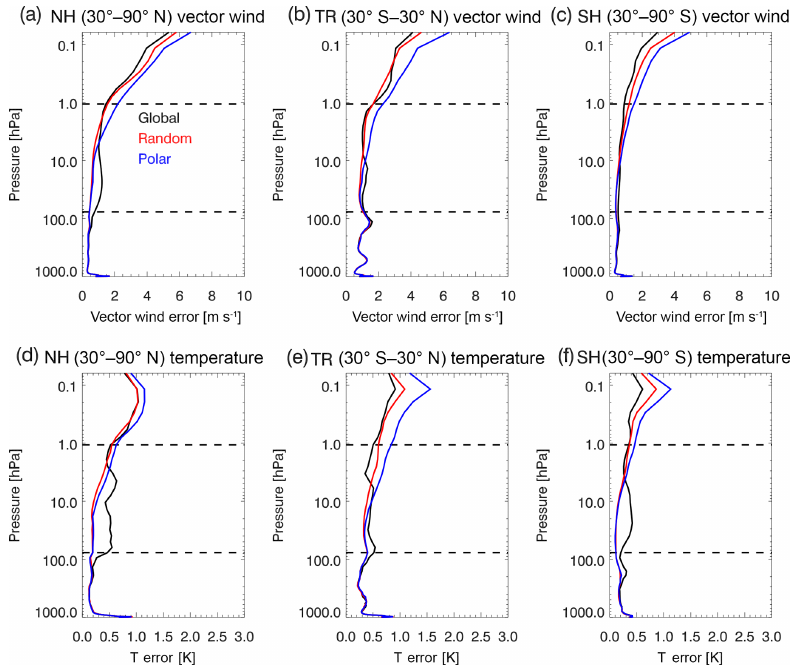
Figure 14. The rms vector wind errors (ms − 1 ) for (a) NH, (b) TR, and (c) SH and rms temperature errors (K) for the (d) NH, (e) TR, and (f) SH averaged from 25 November to 1 December 2014 for experiments that assimilated perfect global (black), random (red), and polar- orbiting (blue) ozone data with unperturbed initial conditions. Horizontal dashed lines indicate vertical range of assimilated stratospheric ozone observations. See Table 1, Sect.